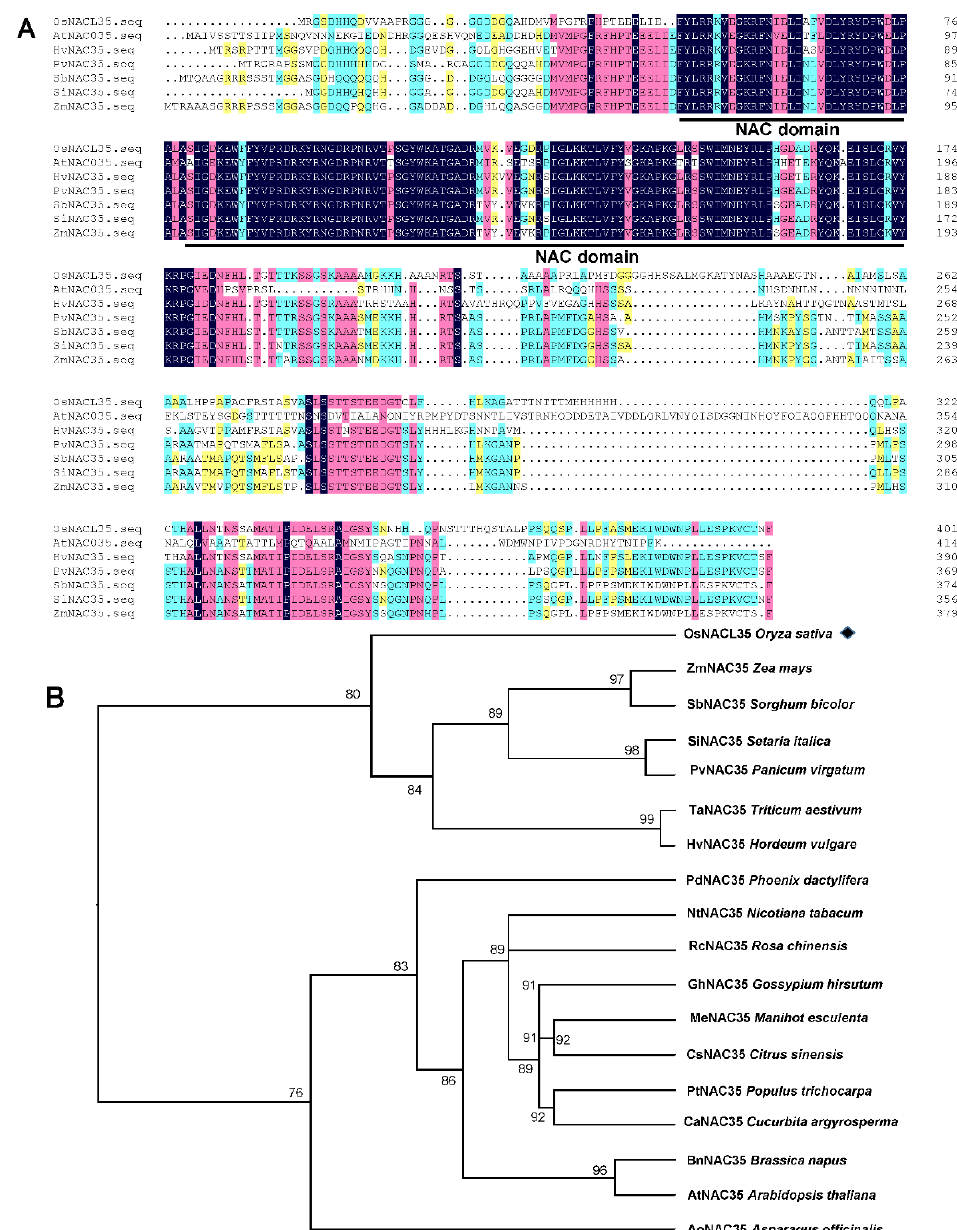
Figure 1. Phylogenetic analysis of OsNACL35. ( A ) Multiple protein sequence alignment of OsNACL35 with other NAC35-like proteins from Arabidopsis, Hordeum, Panicum, Sorghum, Setaria and maize . The conserved NAC domains are marked as bold line. ( B ) Phylogenetic tree analysis of OsNACL35 (indicated by black diamond) with other known plant NAC35 proteins. The accession numbers of these NAC35 protein as follows: Zea mays (NP_001159214.1), Sorghum bicolor